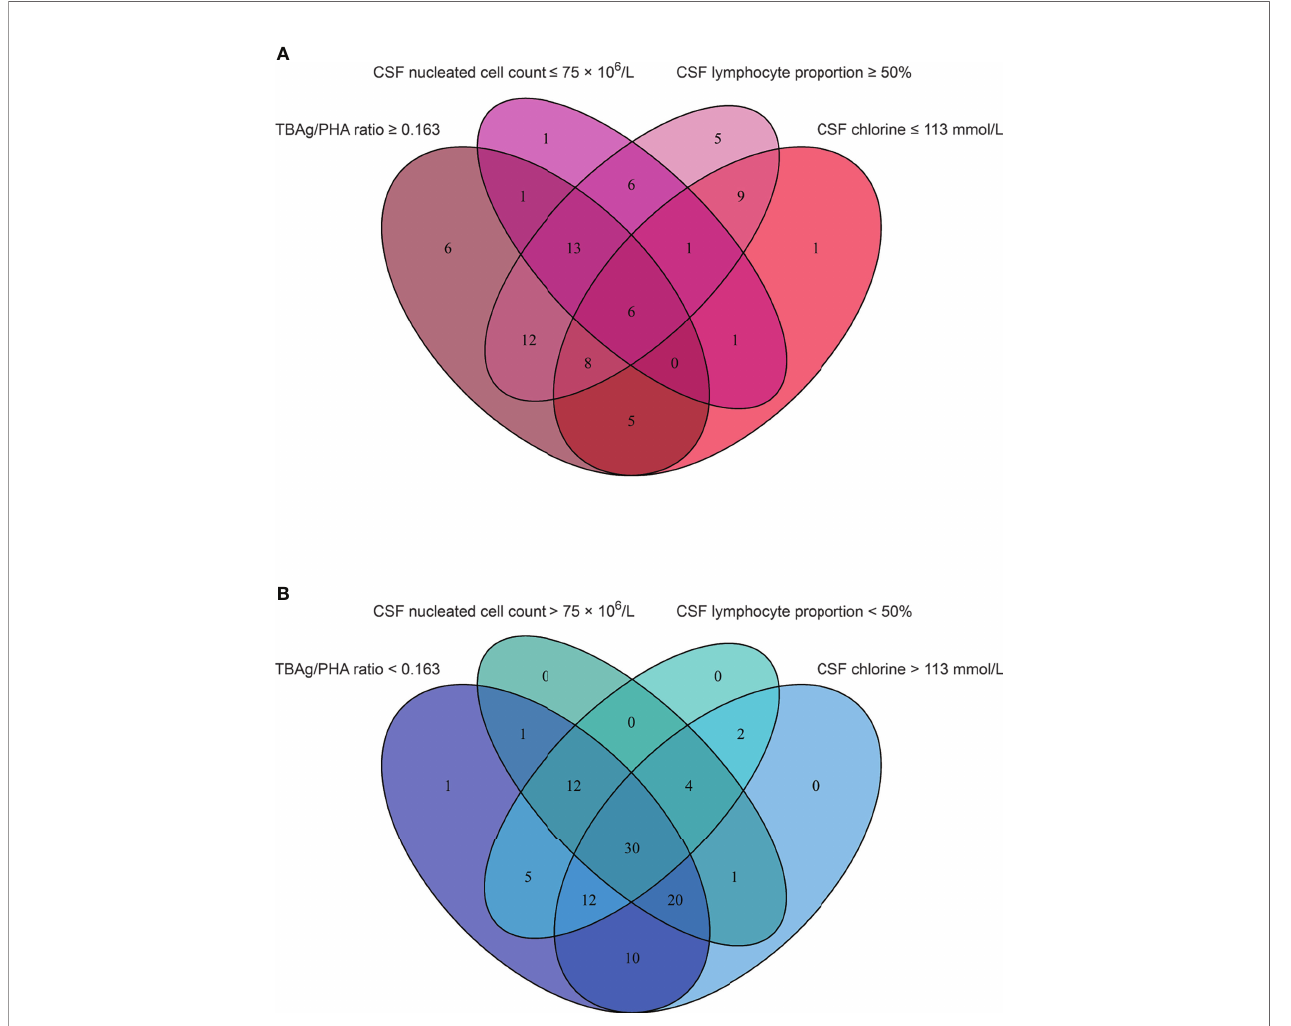
FIGURE 5 | The cross set between various indicators in TBM group and BM group. (A) Venn diagrams showing the overlap of TBAg/PHA ratio, CSF nucleated cell count, CSF lymphocyte proportion, and CSF chlorine in TBM patients. (B) Venn diagrams showing the overlap of TBAg/PHA ratio, CSF nucleated cell count, CSF lymphocyte proportion, and CSF chlorine in BM patients. TBM, tuberculous meningitis; BM, bacterial meningitis; TBAg, tuberculosis-speci fi c antigen; PHA, phytohemagglutinin; CSF, cerebrospinal fl